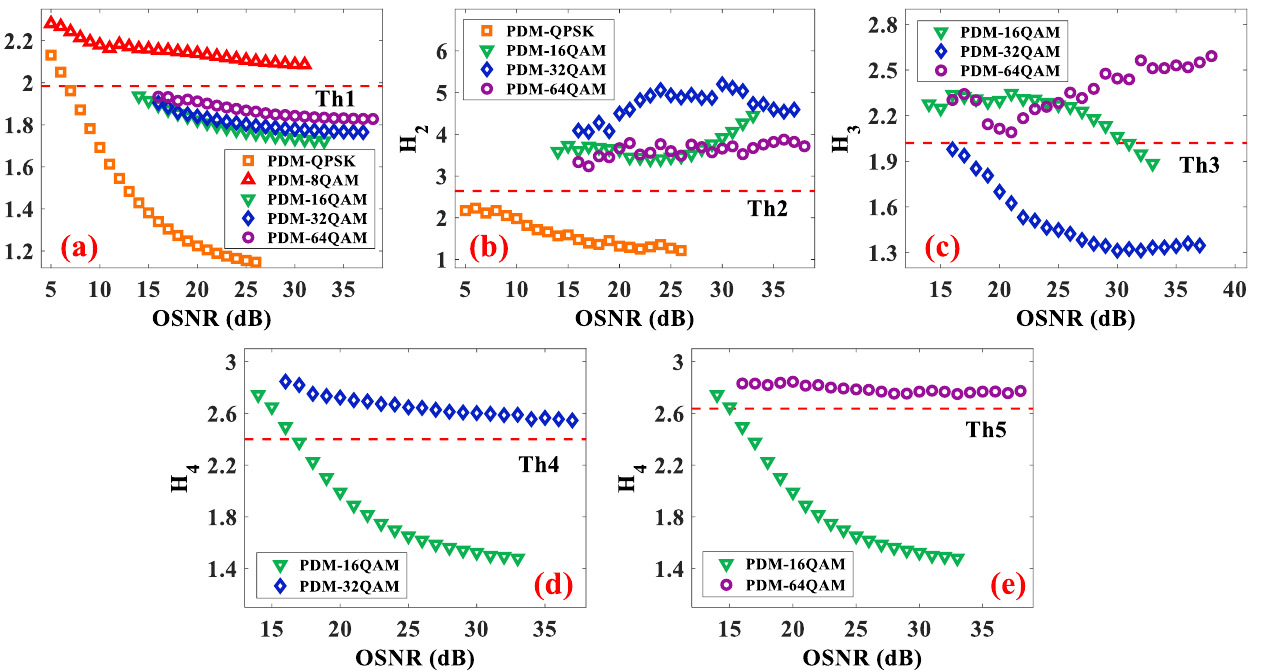
Figure 6. Ratios varies with OSNR in back-to-back simulation: ( a ) H 1 ; ( b ) H 2 ; ( c ) H 3 ; ( d ) H 4 (for separating 16QAM and 32QAM); ( e ) H 4 (for separating 16QAM and 64QAM). The dotted red lines indicate the corresponding thresholds.